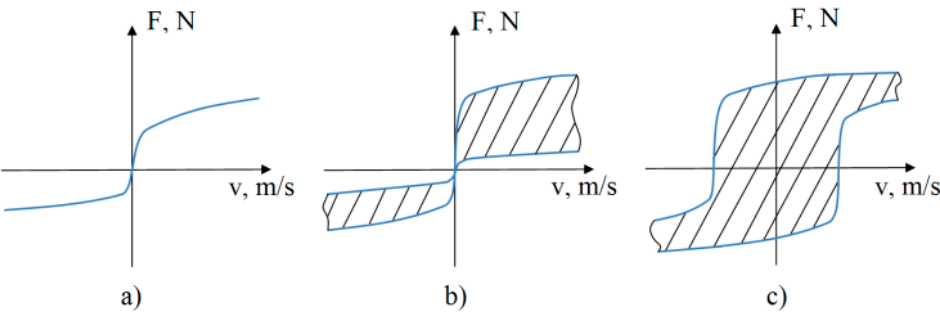
Figure 1. Dissipative characteristics: ( a ) passive, ( b ) semi active, ( c ) active shock absorber. In an active shock absorber, the set of dissipative characteristics cover all IV quadrants due to an external energy source, and force and velocity vectors can be oppositely directed. This property is the great advantage of active shock absorbers, and it allows, in theory, the achievement of a complete absence of movement of the vehicle body for the given